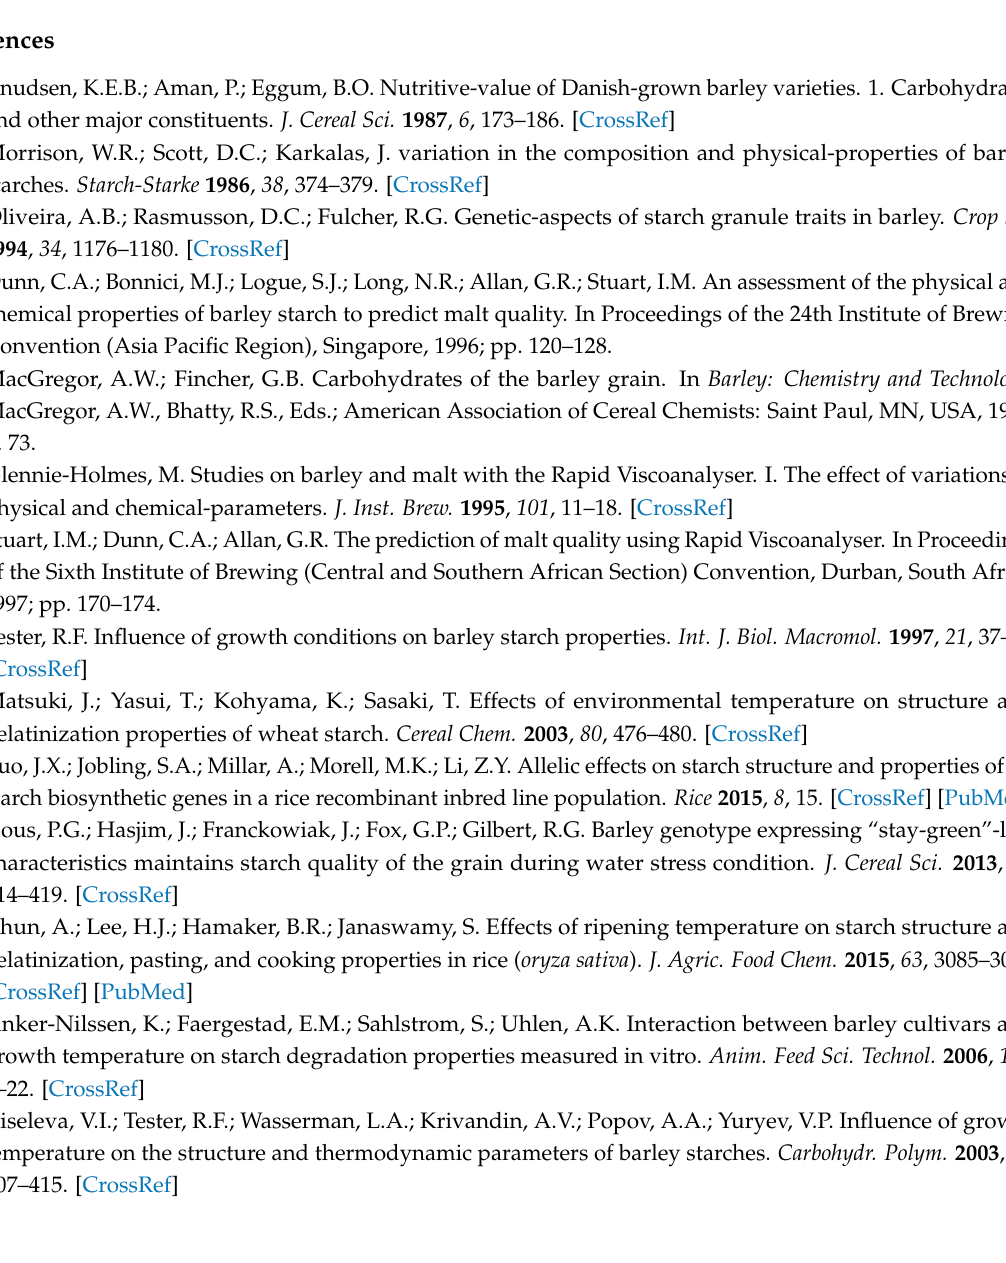
s1. Figure S1: QTL for pasting properties QTL (in green) and malt extract (in red). For greater clarity, only selected markers and closest markers to different QTL were